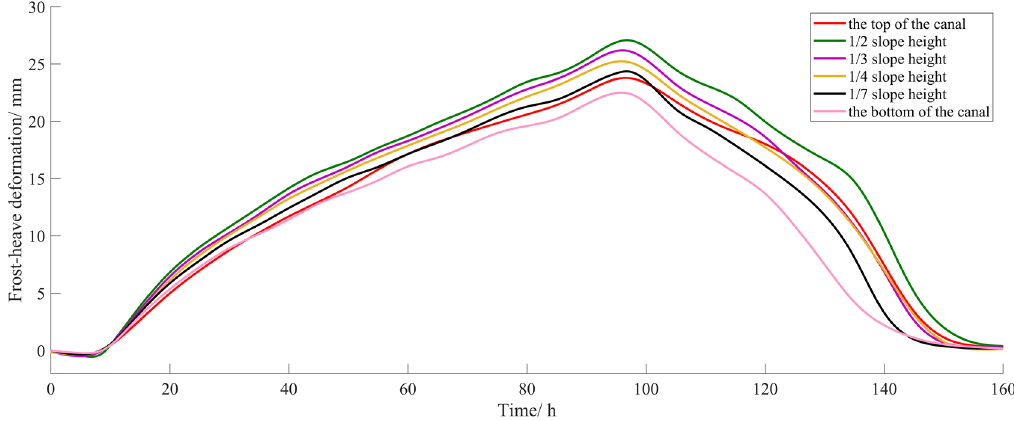
Figure 12. Time-history curves of the frost heave deformation at di ff erent positions.